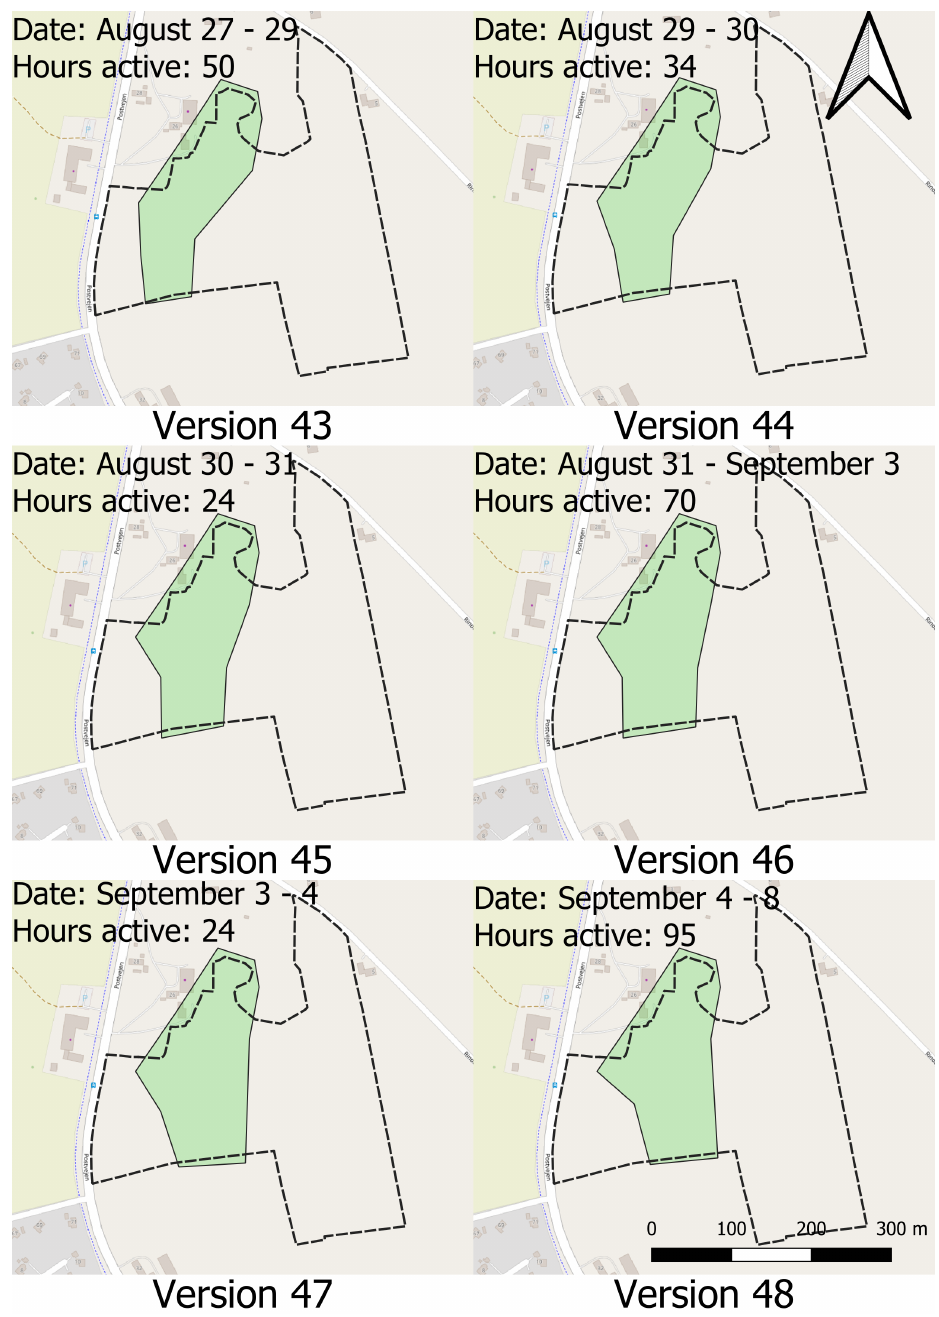
Figure A8. Virtual enclosure version 8 dating from 27 August to 8 September. The dashed black line represents the physical fence surrounding the 8.2 ha grazing area. The marked green area represents the virtual enclosure. Only virtual enclosures active for more than 12 h were included. The coordinates of the upper left corner of the map frame are 55°25 (cid:48) 23.131 (cid:48)(cid:48) E 8°23 (cid:48) 53.531 (cid:48)(cid:48) N. Map data from OpenStreetMaps